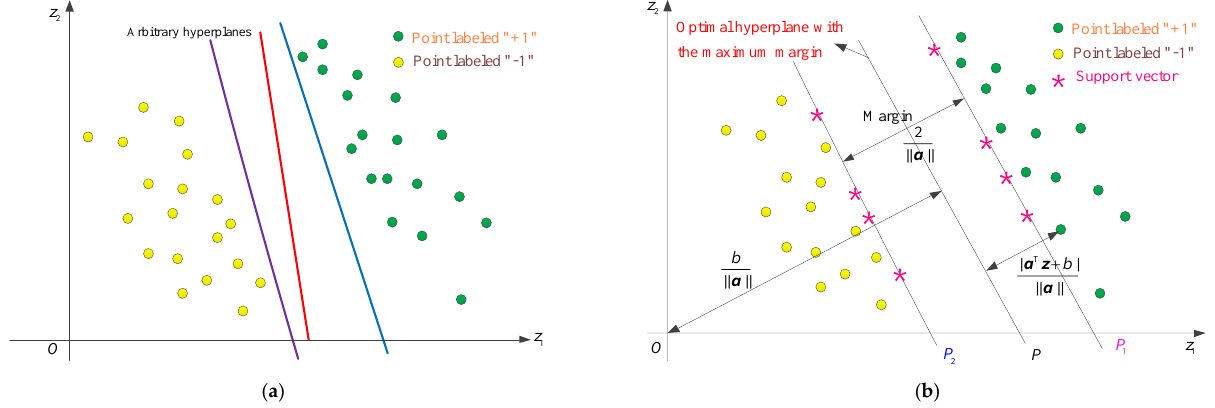
Figure 5. Illustration of decision hyperplanes. ( a ) Arbitrary classification hyperplanes; ( b ) Optimal classification hyperplane.